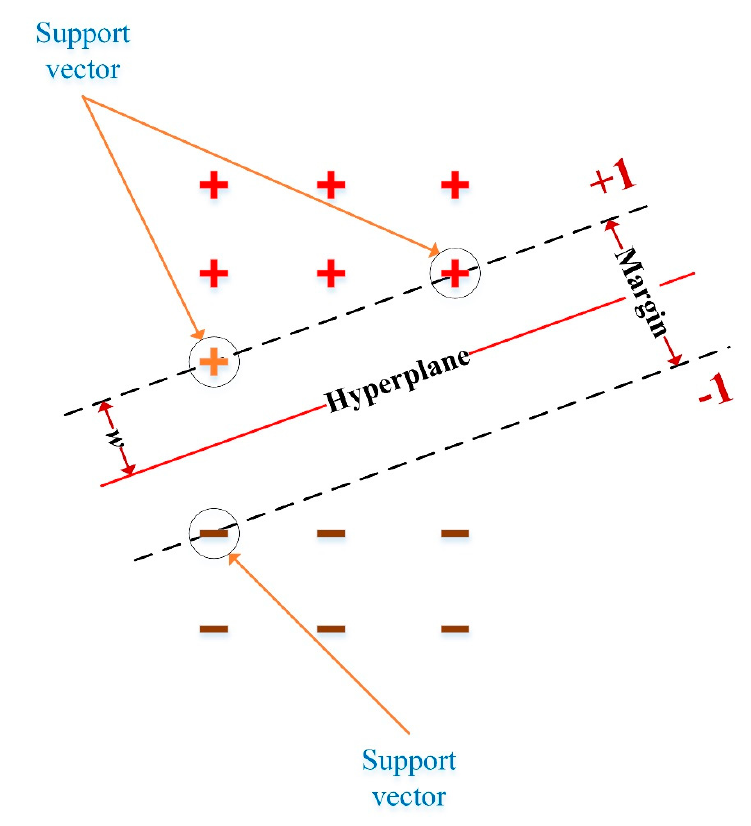
Figure 2. Representation of SVM.